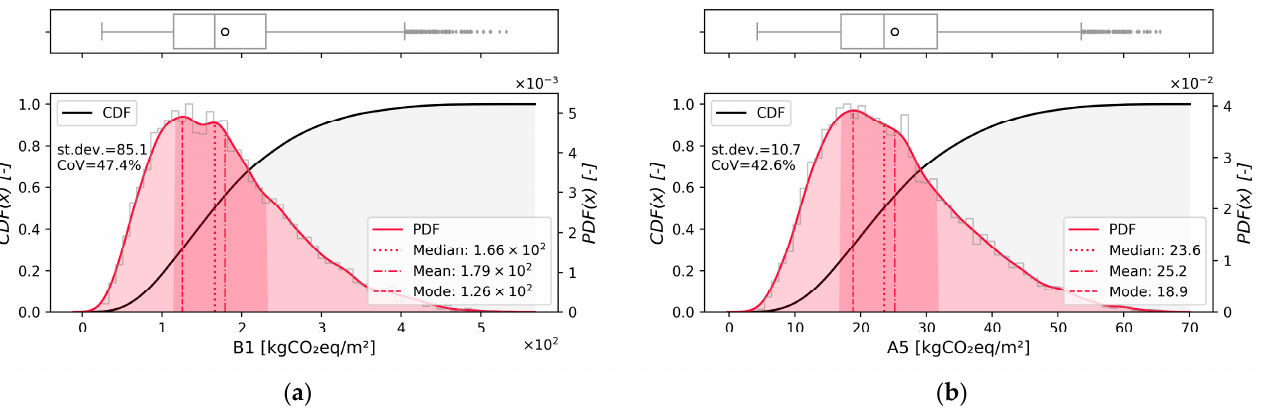
Figure 13. PDFs, CDFs, and box-whisker plots for the GWP related to the relevant stages for: ( a ) A-S2; ( b ) B-S2. In the latter case, only the B1 stage is reported, since it is the only one that differs from A-S1. The EoL and B1 results are not reported, since they are negligible and equal to zero, respectively.